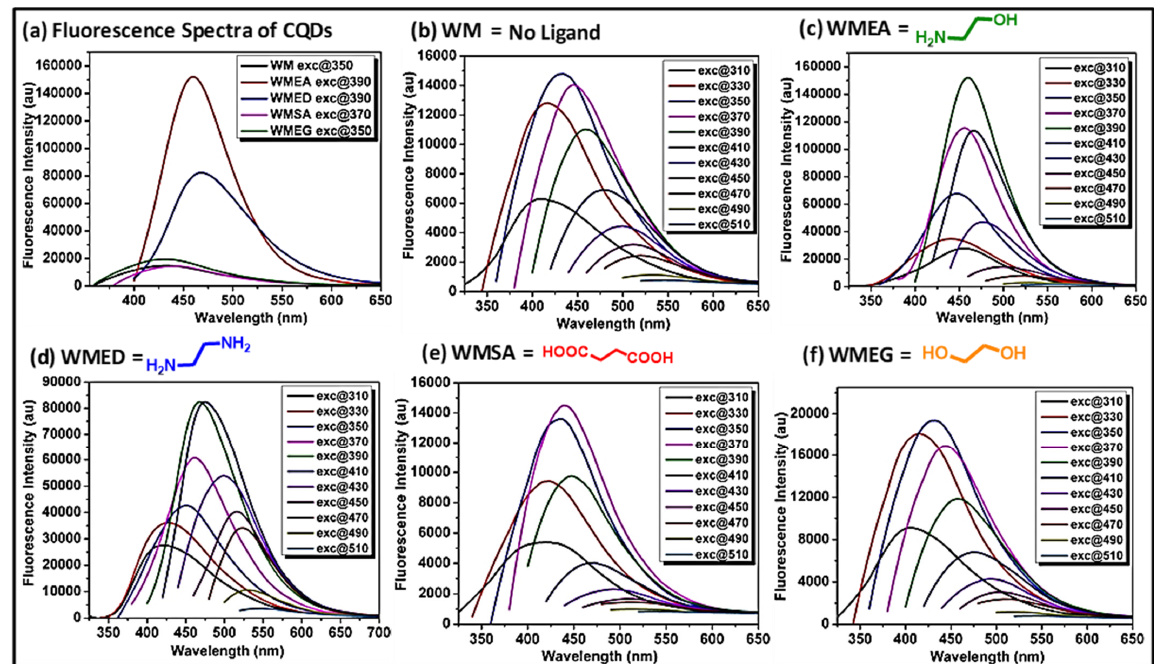
Figure 1. ( a ) Emission spectra of WM-CQDs and WMEG at 350 nm excitation, emission spectra of WMEG-CQDs at 370 nm excitation, emission spectra of WMEA-CQDs and WMED-CQDs at 390 nm excitation, showing intensity difference by introducing different surface passivating agents. Excitation-dependent emission spectra of ( b ) WM-CQDs; ( c ) WMEA-CQDs; ( d ) WMED-CQDs; ( e ) WMSA-CQDs; and ( f ) WMEG-CQDs obtained by hydrothermal treatment at different